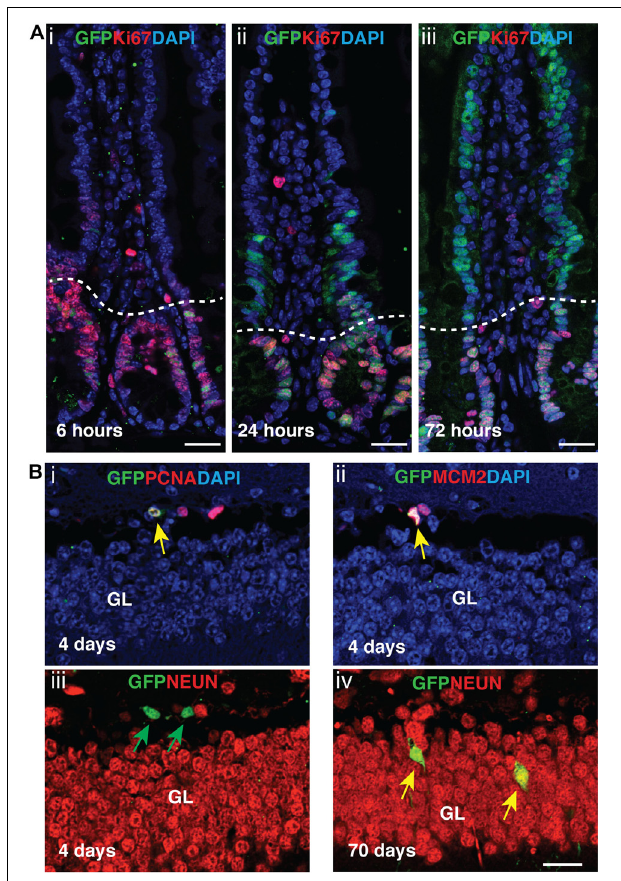
FIGURE 6 | Tamoxifen activation of Aurkb ER Cre / + labels proliferating stem cells/progenitor cells in adult intestines and brain. (A) Aurkb ER Cre / + labeling in adult intestines. A single dose of tamoxifen (100 mg/kg BW, i–iii) was intraperitoneally given to Aurkb ER Cre / + ; R26R eYFP / + mice at the age of 2 months. Dotted lines delineate the crypts below from their associated villus above. Bars, 25 µ m; (B) Aurkb ER Cre / + labeling in adult brain. Tamoxifen (100 mg/kg BW) was intraperitoneally given daily to Aurkb ER Cre / + ; R26R eYFP / + mice for four consecutive days at the age of 2 months. Green arrows point to GFP+ only cells; yellow arrows point to GFP+; PCNA+ (i), GFP+; MCM2+ (ii) or GFP+; NeuN+ (iv) cells. GL, granular layer. Bars, 20 µ